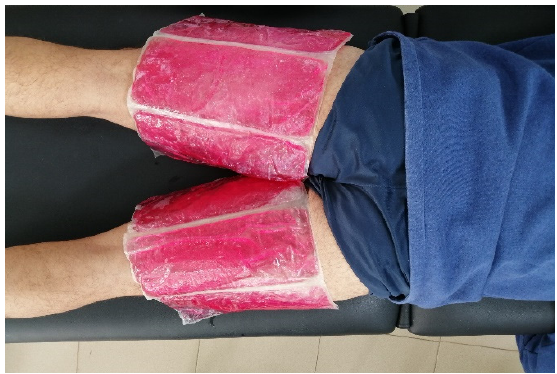
Figure 3. Static warm-up method with standard-size hot packs.